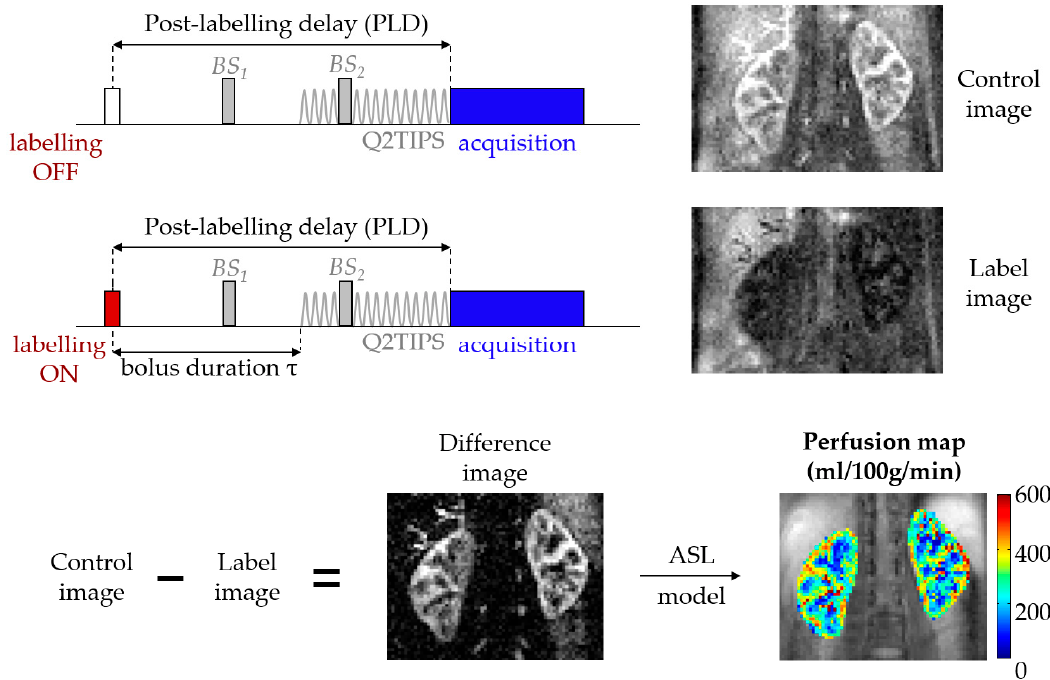
Figure 1. Arterial spin labeling (ASL) overview. The background suppression (BS) pulses are optional but were used to acquire the renal ASL images in this example, hence the marked difference between control and labeled images (in healthy volunteers, the amount of signal due to inflowing blood is in the order of 5% of the non-background suppressed baseline tissue magnetization). The QUIPSS II with thin-slice TI1 periodic saturation (Q2TIPS) method [7] allows one to define the bolus duration in single post-labeling delay (single-PLD) pulsed ASL (PASL)